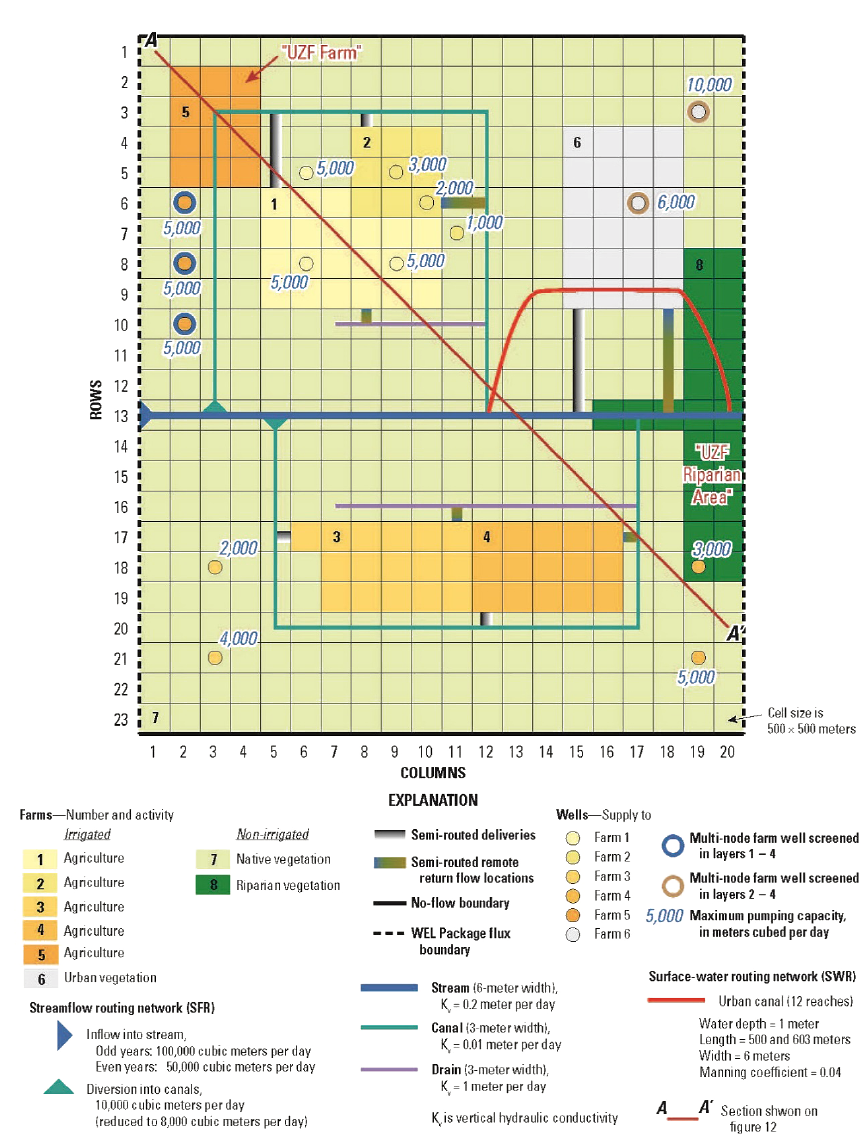
Figure 1. Plan view of model domain, grid resolution, boundary conditions, distribution of farms and farm wells, and streamflow routing network with points of diversion to farms and points of return flow from farms and surface-water canal traversing urban area (Schmid et al.,